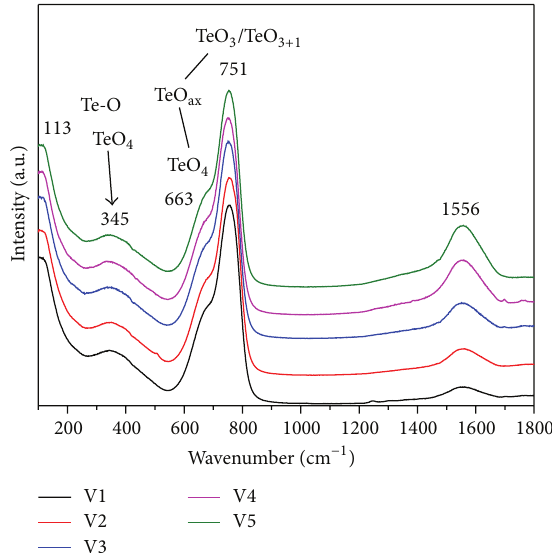
Figure 4: Raman spectra of the ZnO-CdO-TeO 2 with different Eu 3+ ions content. The introduction of ZnO and CdO in the glass matrix induced the formation of TeO 3+1 and TeO 3 groups.